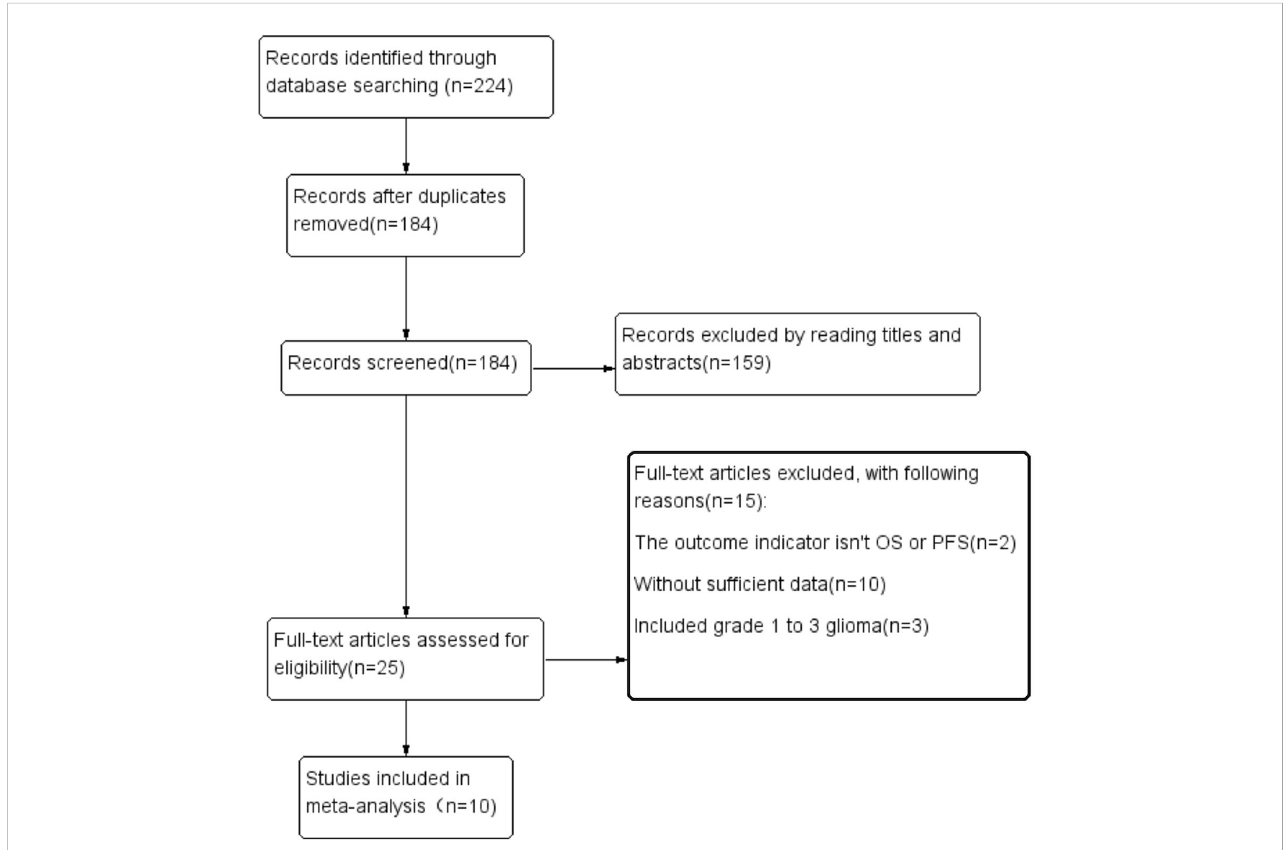
FIGURE 1 Flowchart of the article search